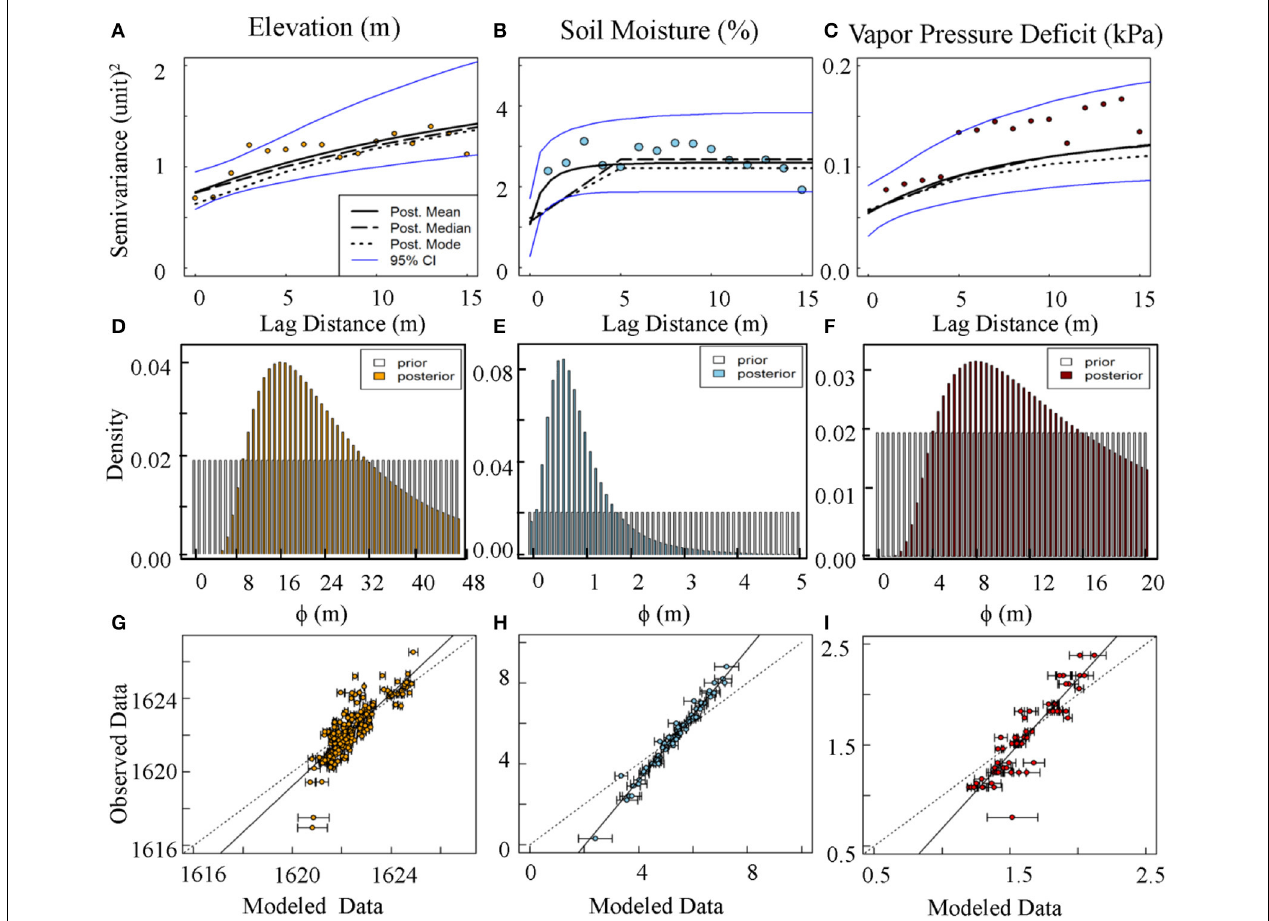
FIGURE A1 | Semivariogams (A–C), prior and posterior distribution of range parameter (range = 3 (cid:2) ) (D–F), and cross-validation graphs (G–I) associated with elevation, soil moisture, and vapor pressure deficit.